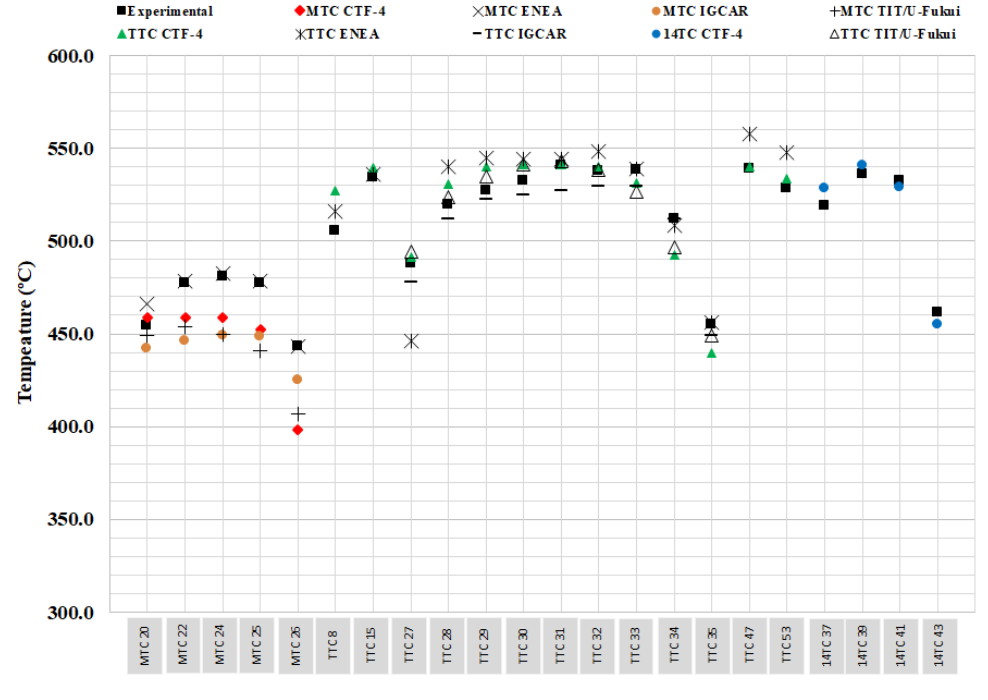
Figure 2. SHRT-17 steady state temperature predictions for XX09